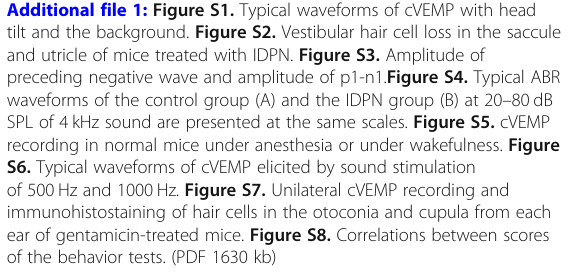
Additional file 1: Figure S1. Typical waveforms of cVEMP with head tilt and the background. Figure S2. Vestibular hair cell loss in the saccule and utricle of mice treated with IDPN. Figure S3. Amplitude of preceding negative wave and amplitude of p1-n1. Figure S4. Typical ABR waveforms of the control group (A) and the IDPN group (B) at 20 – 80dB SPL of 4 kHz sound are presented at the same scales. Figure S5.